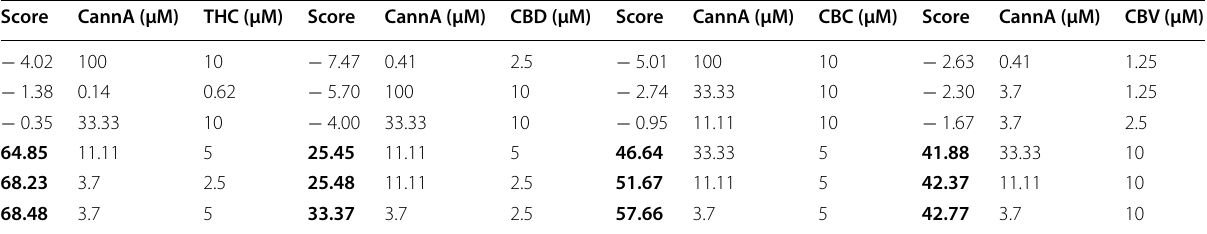
A score < 10 is likely antagonistic (italic); between −